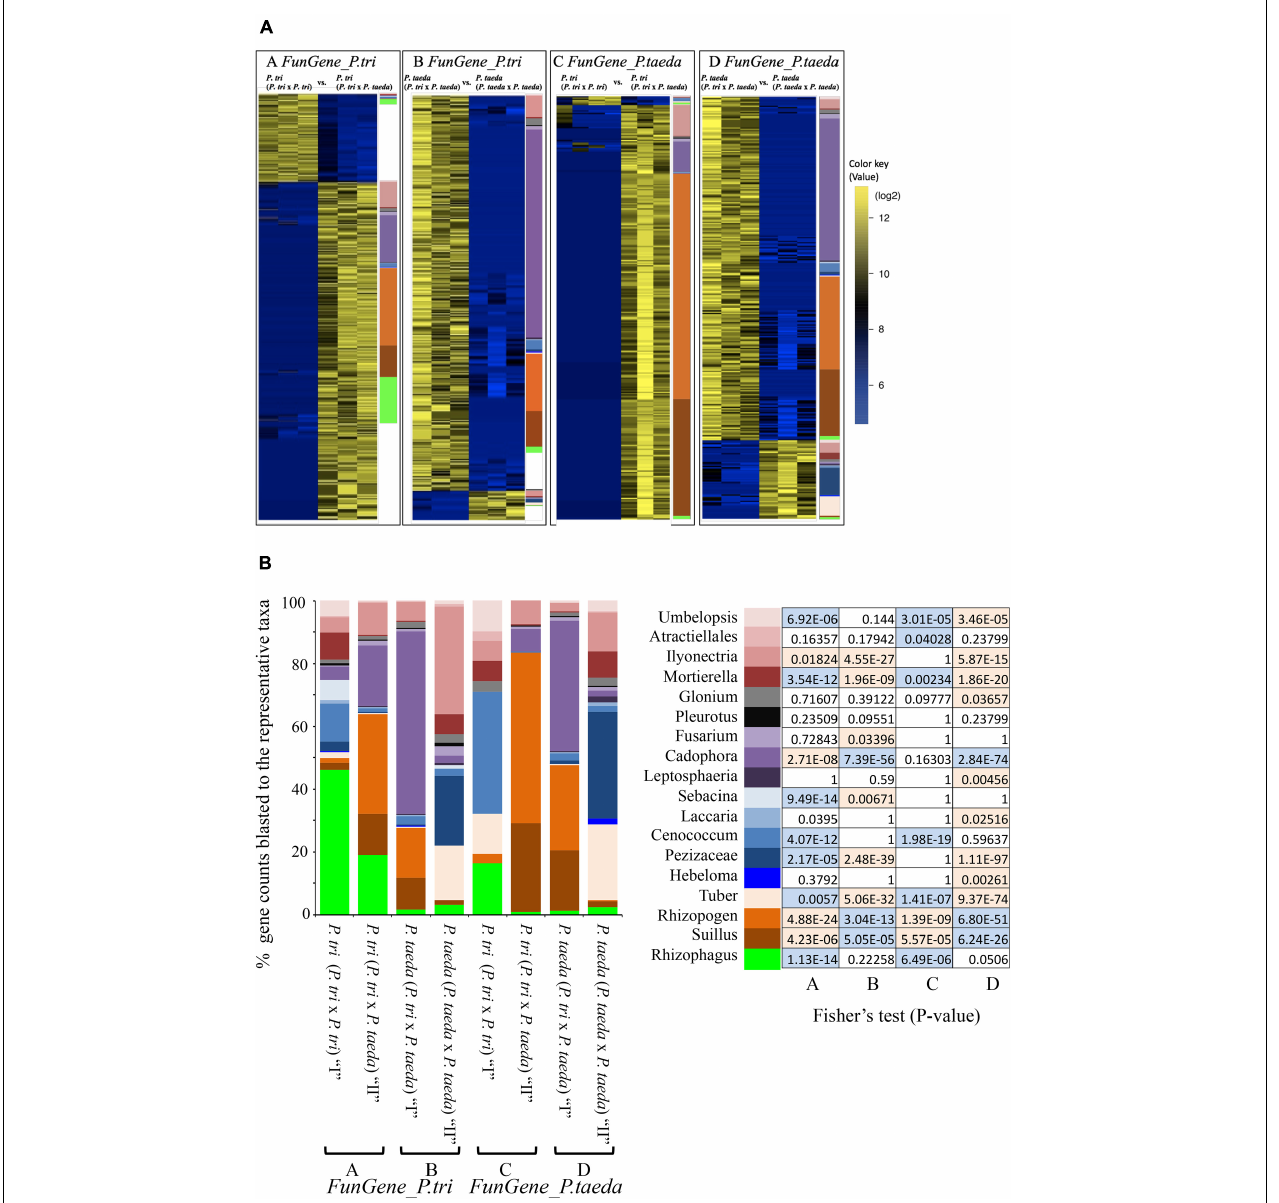
FIGURE 7 | The changes in expression of two sets of fungal genes ( FunGene_P. tri –A and B and FunGene_P. taeda –C and D) underlying different plant combinations. (A) Heat maps showing relative expression patterns of the FunGene_P. tri and FunGene_P. taeda that were up- or down-regulated in response to the plant traits (data were extracted from the color dots in Figure 4 ). The color bar on the right side of each heatmap [as well as in (B)] represents the numbers of genes assigned to predicted fungal taxa through blast (BlastX) to the fungal protein databases (method in Supporting Information Text A2). Data that were used to generate heatmaps are presented in Supplementary Dataset 3 . Significant changes of gene expression were clustered according to ecological functions of fungal taxa, including AMF, EMF, Pathogens, Saprotrophs, and endophytes ( > 2-fold changes; FDR < 0.05). The color key represents RPKM normalized log2 transformed counts of the genes. Wilcoxon signed-rank test (Bauer, 1972) was applied to filter data. (B) Fisher’s test was used to identify enrichment of genes from the individual taxa underlying 2 × 2 matrix. Boxes in blue showed the genes of the individual taxa were enriched in “I” vs. “II.” Boxes in orange showed the genes of the individual taxa were enriched in “II” vs. “I” ( P <